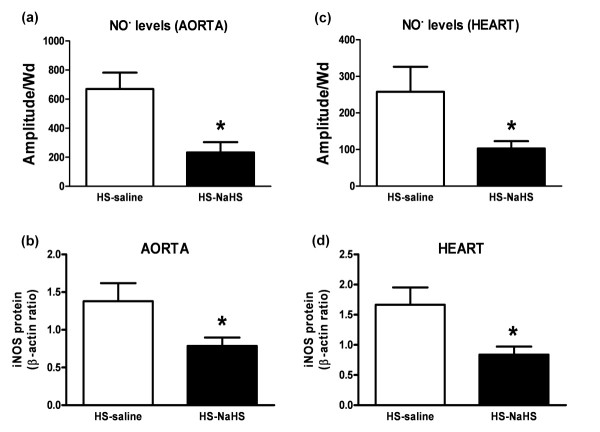
NaHS administration reduces NO production and iNOS expression in aorta and heart. (a, c) Quantification of the amplitude of NO-Fe(DETC)2 signal in unit/weight (mg of the dried sample Amplitude/Wd, n = 10) in the aorta (a) and heart (c) of the two groups of rats. (b, d) Western blots revealing iNOS expression in the in the whole lysate of aortas (n = 6) (b) and in hearts (n = 6) (d) of two groups of rats. Densitometric analysis was used to calculate normalized protein ratio (protein to β-actin). Data are expressed as mean ± SD. *P < 0.05, significantly different between HS-saline and HS-NaHS groups.